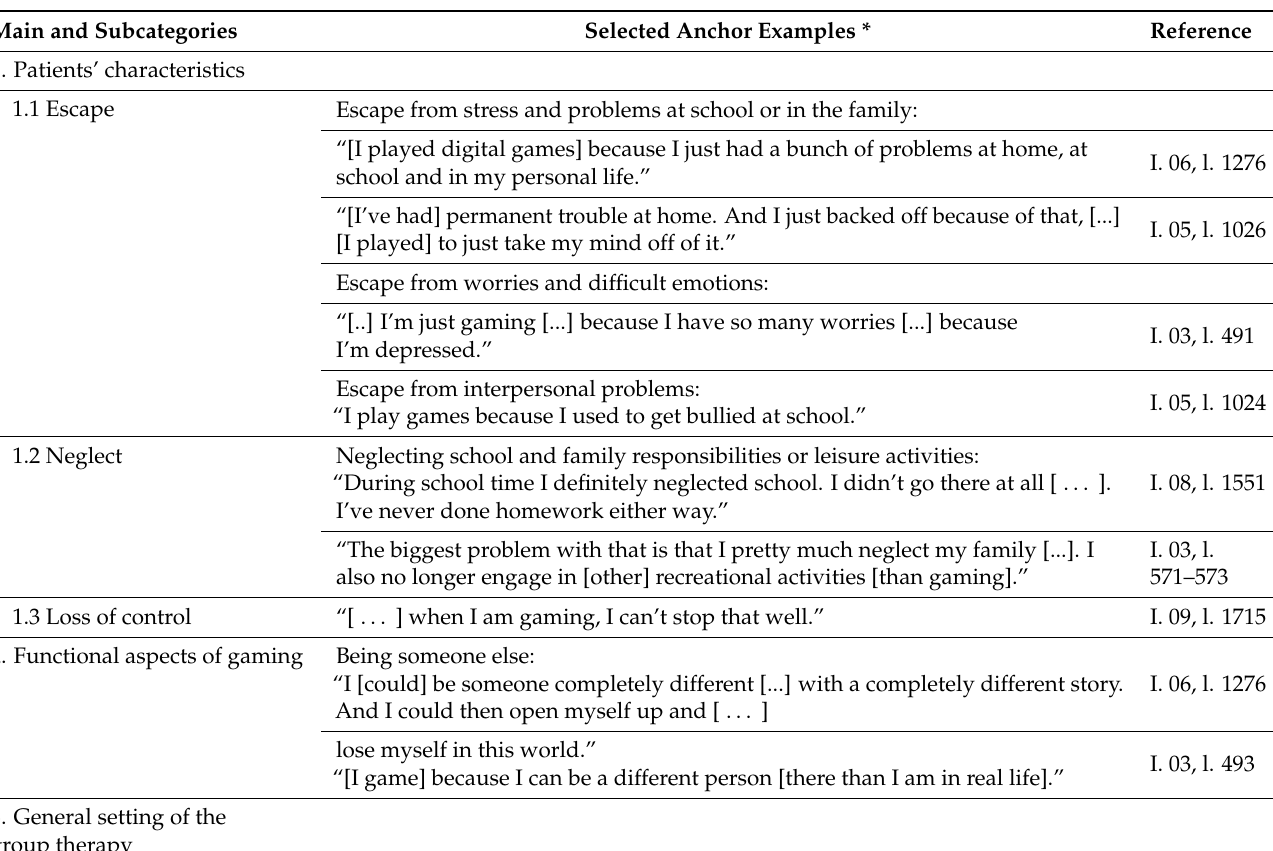
Table 3. Main categories and subcategories of the patient interviews with their anchor examples. Main and Subcategories Selected Anchor Examples *